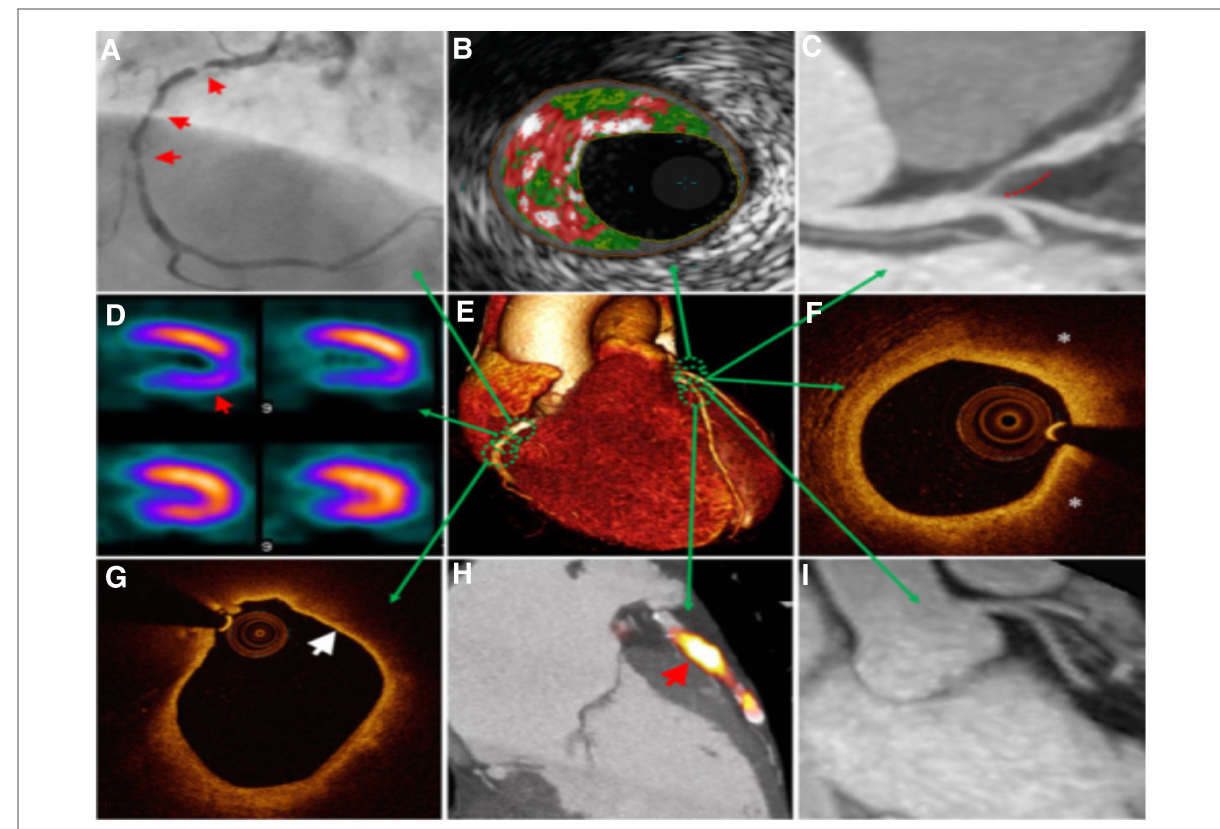
FIGURE 5 Multimodal technique to atherosclerosis imaging. Each modality offers respective measurements to aid in diagnosis or treatment. Combining the information on anatomic and hemodynamic properties, calci fi cation, and metabolic activity allows accurate analysis of an individual patient. ( A ) X-ray angiography with atherosclerotic lesions (arrows); ( B ) Histology intravascular ultrasound illustrating plaque with elevated content of necrotic core (red), calcium (white), and fi bro-fatty regions (dark/light green); ( C ) CT angiography revealing non-calci fi ed plaque in the left anterior descending artery (dashed line); ( D ) SPECT myocardial perfusion scan with stress-induced perfusion defect (arrow); ( E ) 3D CT whole-heart image; ( F ) Optical coherence tomography (OCT) image of calci fi cation showing lipid (*); ( G ) OCT image showing thin overlying fi brous cap (arrow), indicative of thin-cap fi broatheroma; ( H ) PET – CT image displaying active microcalci fi cation; (I) MRI contrast-angiography showing clear delineation of coronary vessels